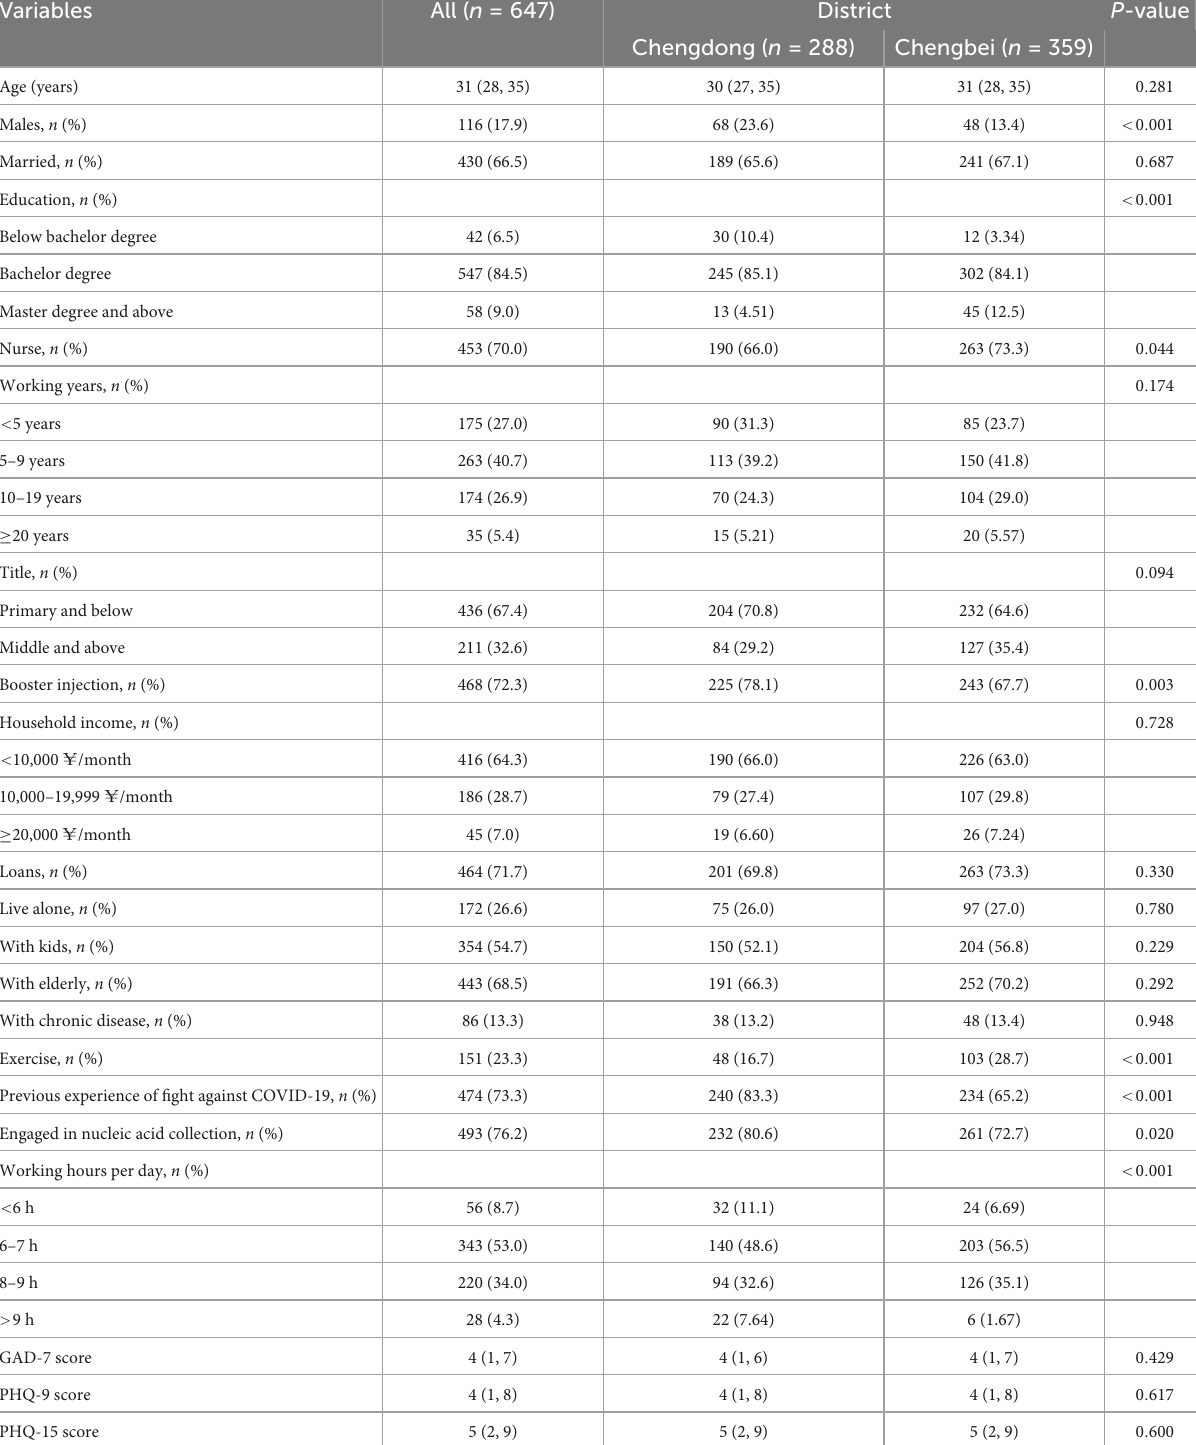
TABLE 1 Baseline characteristics of Chengdong and Chengbei